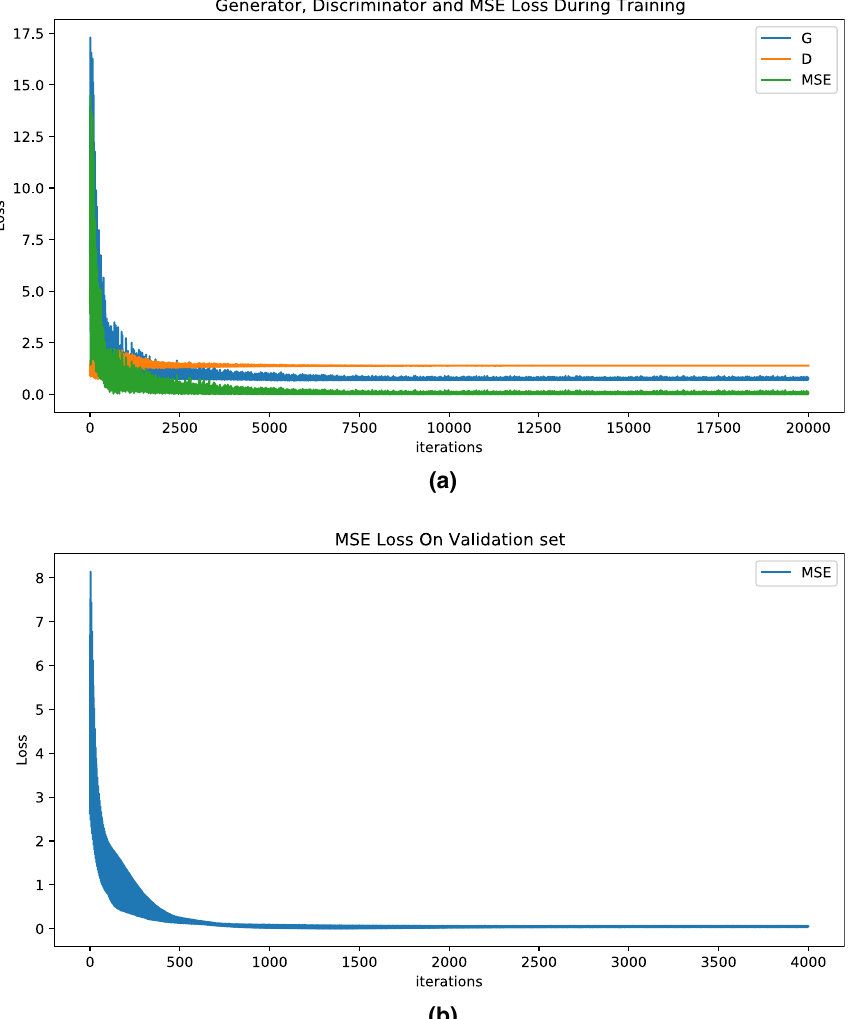
Figure 3. The above figures show the losses on train set and validation set specifically.